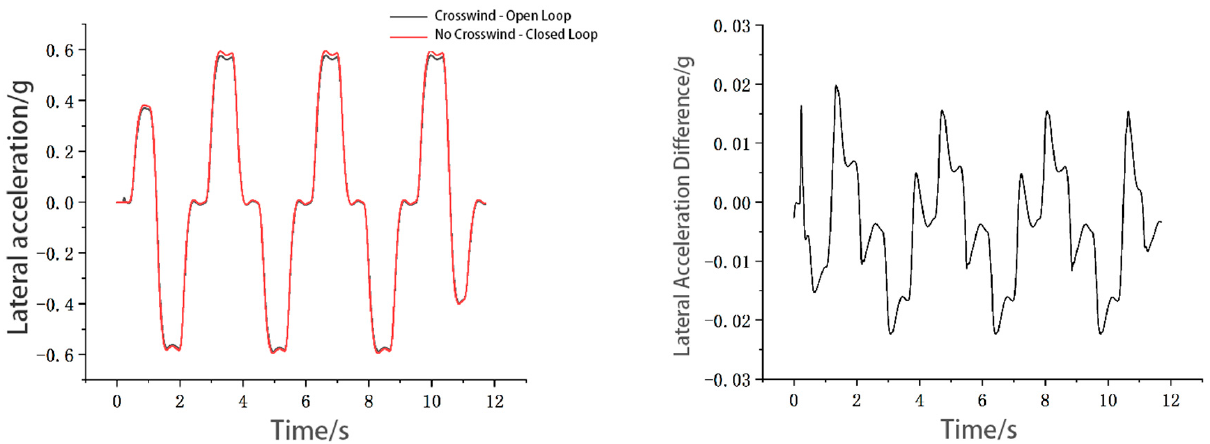
Figure 16. Comparison curve and difference curve of lateral acceleration with and without cross- wind effect.